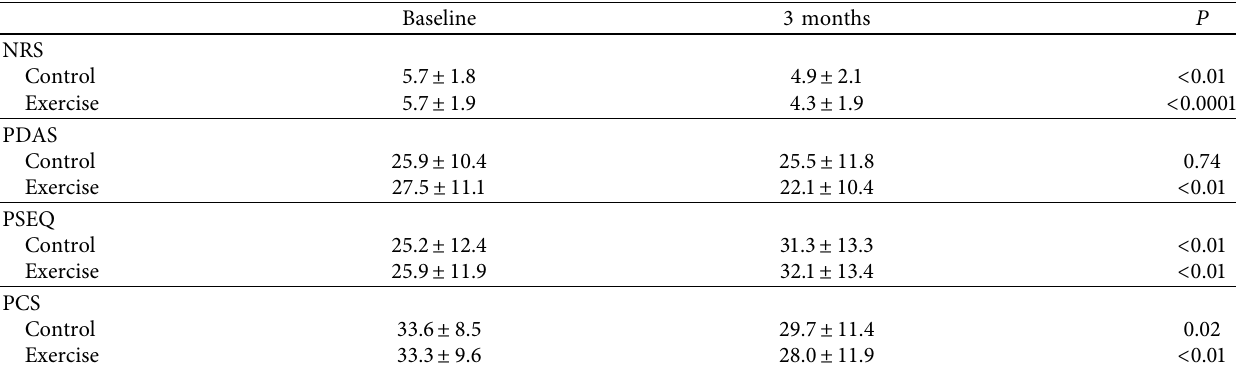
Table 2: Changes in pain, disability, and pain-related psychological status during the 3-month follow-up